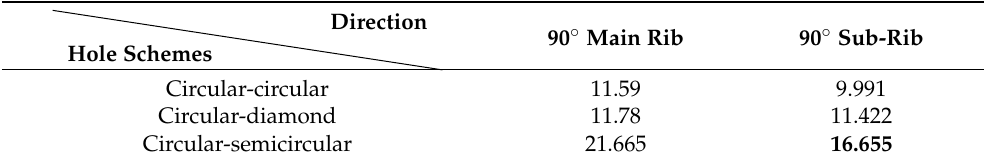
Table 4. Effective tensile strength of performance optimization multi-axial geogrid with deferent pre-punched holes